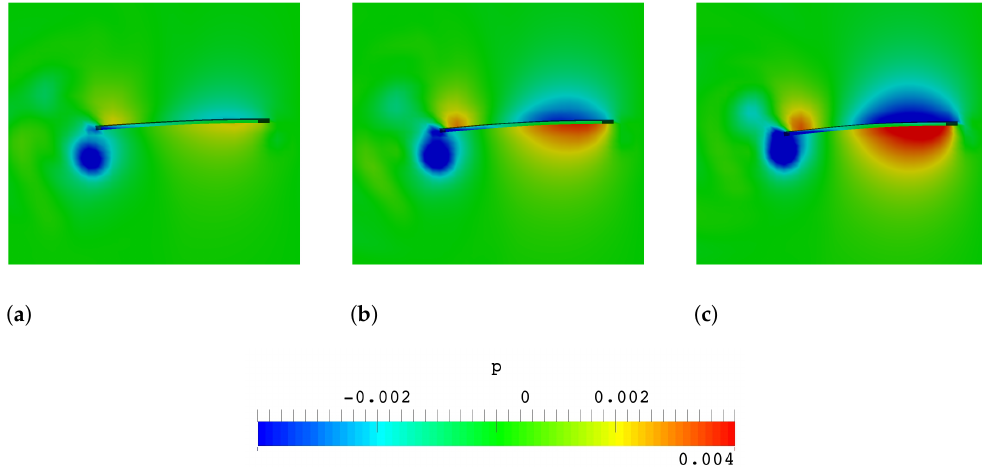
Figure 13. Pressure distributions on the spanwise symmetry plane of the plate at a phase instant when a peak value of negative thrust appears for the case of: ( a ) f ∗ = 0.93. ( b ) f ∗ = 1.2. ( c ) f ∗ = 1.47.